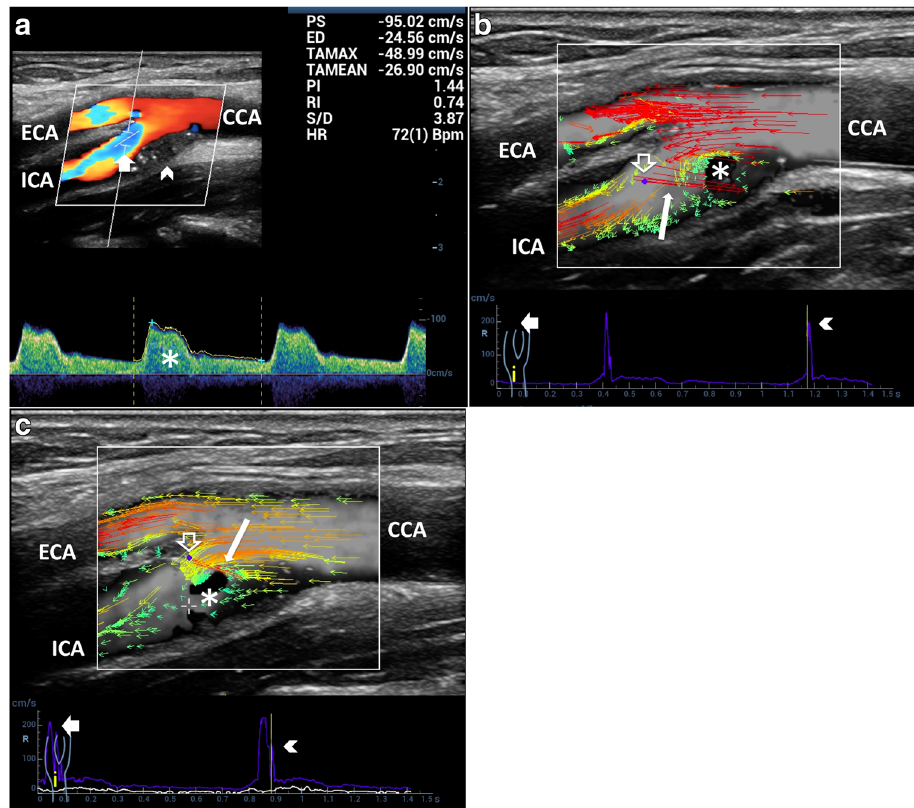
Fig. 10 Flow patterns in low- degree to moderate stenosis. a ) B- mode and CD of the CB show a plaque ( arrowhead ) andincreased velocities in the ICA ( short arrow ), respectively. PW measures a moderate velocity and spectral broadening (*). b) VFI at low PRF, at the peak systole ( arrowhead ) shows high-velocity red vectors. Long red vectors due to aliasing ( arrow ), start at the blue dot ( void arrow ), move back. Vector velocity ( white arrow ) is higher than the measured PW. c) At high PRF, VFI displays the higher velocities at the stenosis level ( orange/yellow vectors ). Reverse red vectors ( arrow ) start from the blue dot ( void arrow ). In b ), c ) recirculation depicted by green vectors (*). CCA = Common carotid artery. ICA = Internal carotid